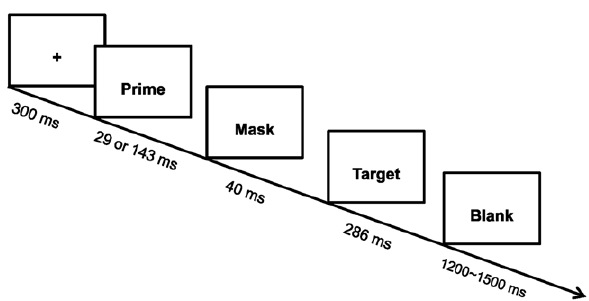
Figure 1. Schematic representation of the experimental